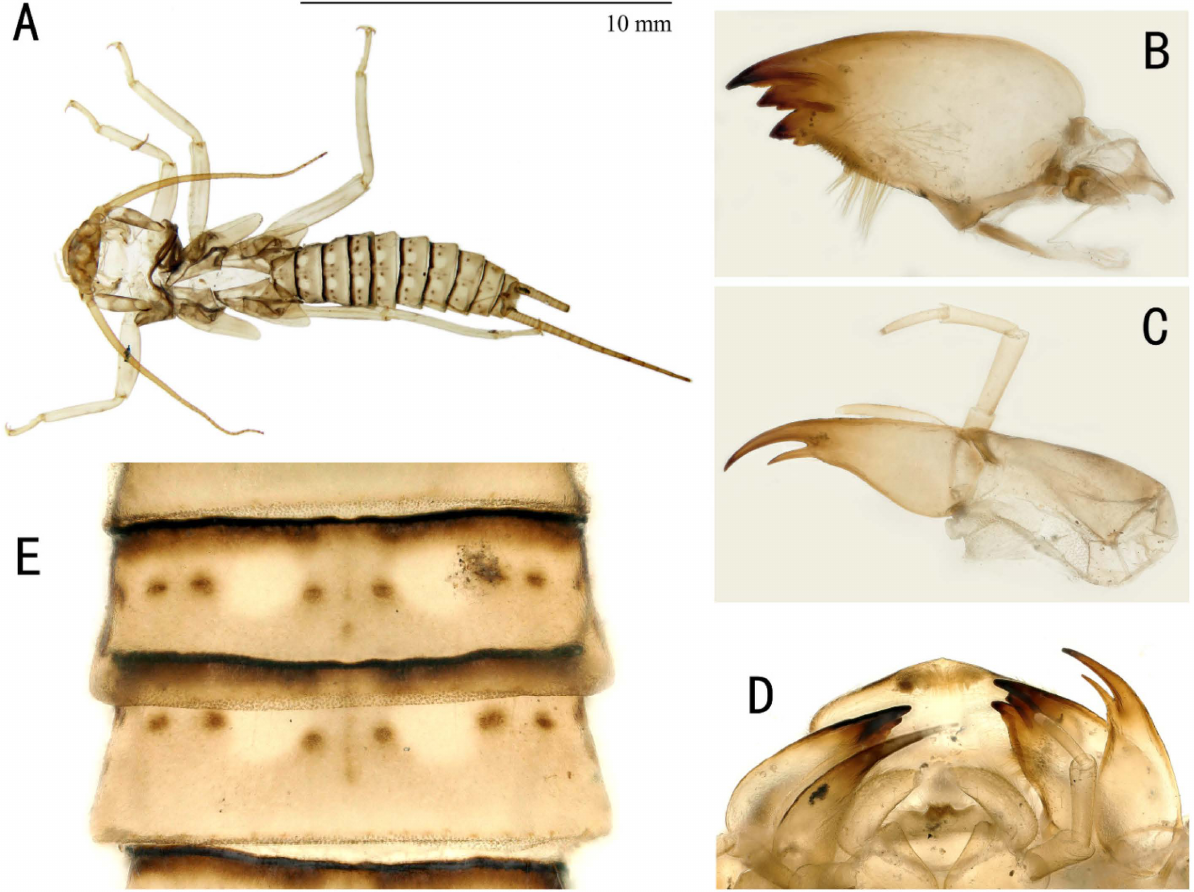
Figure 5. Filchneria songi , shed skin from Taiping National Forest Park. ( A ) nymph habitus; ( B ) mandible; ( C ) lacinia; ( D ) labium, ventral; ( E ) tergal stripes and